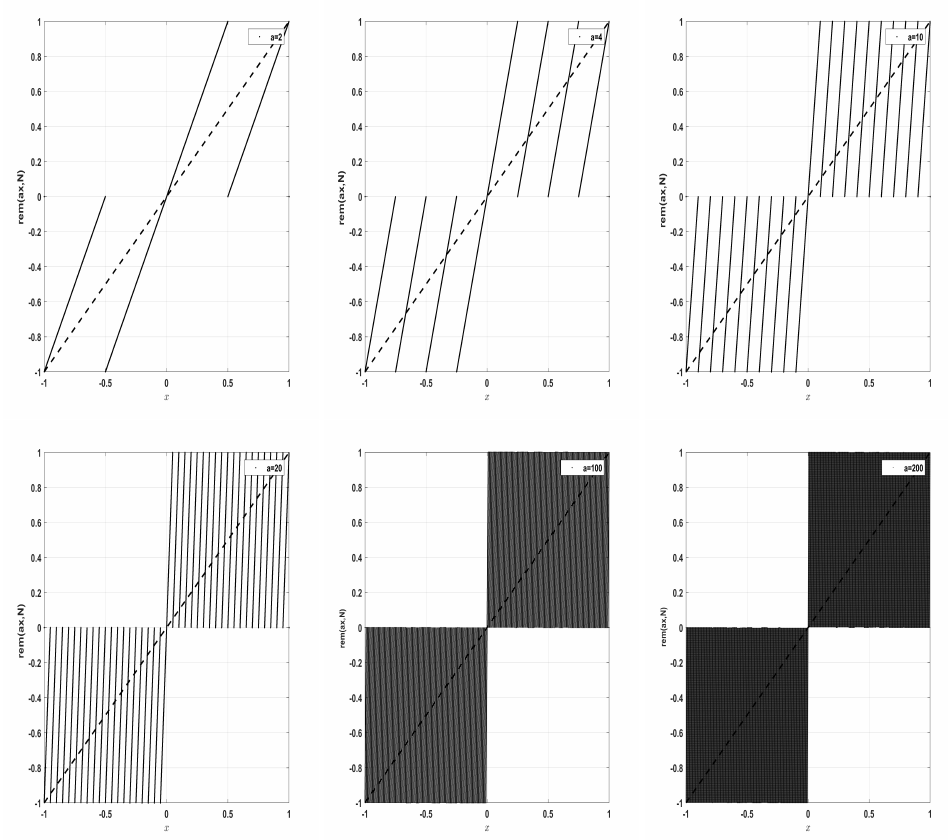
Figure 2. Plot of the function rem ( ax , N ) with respect to x , for different values of a and N =